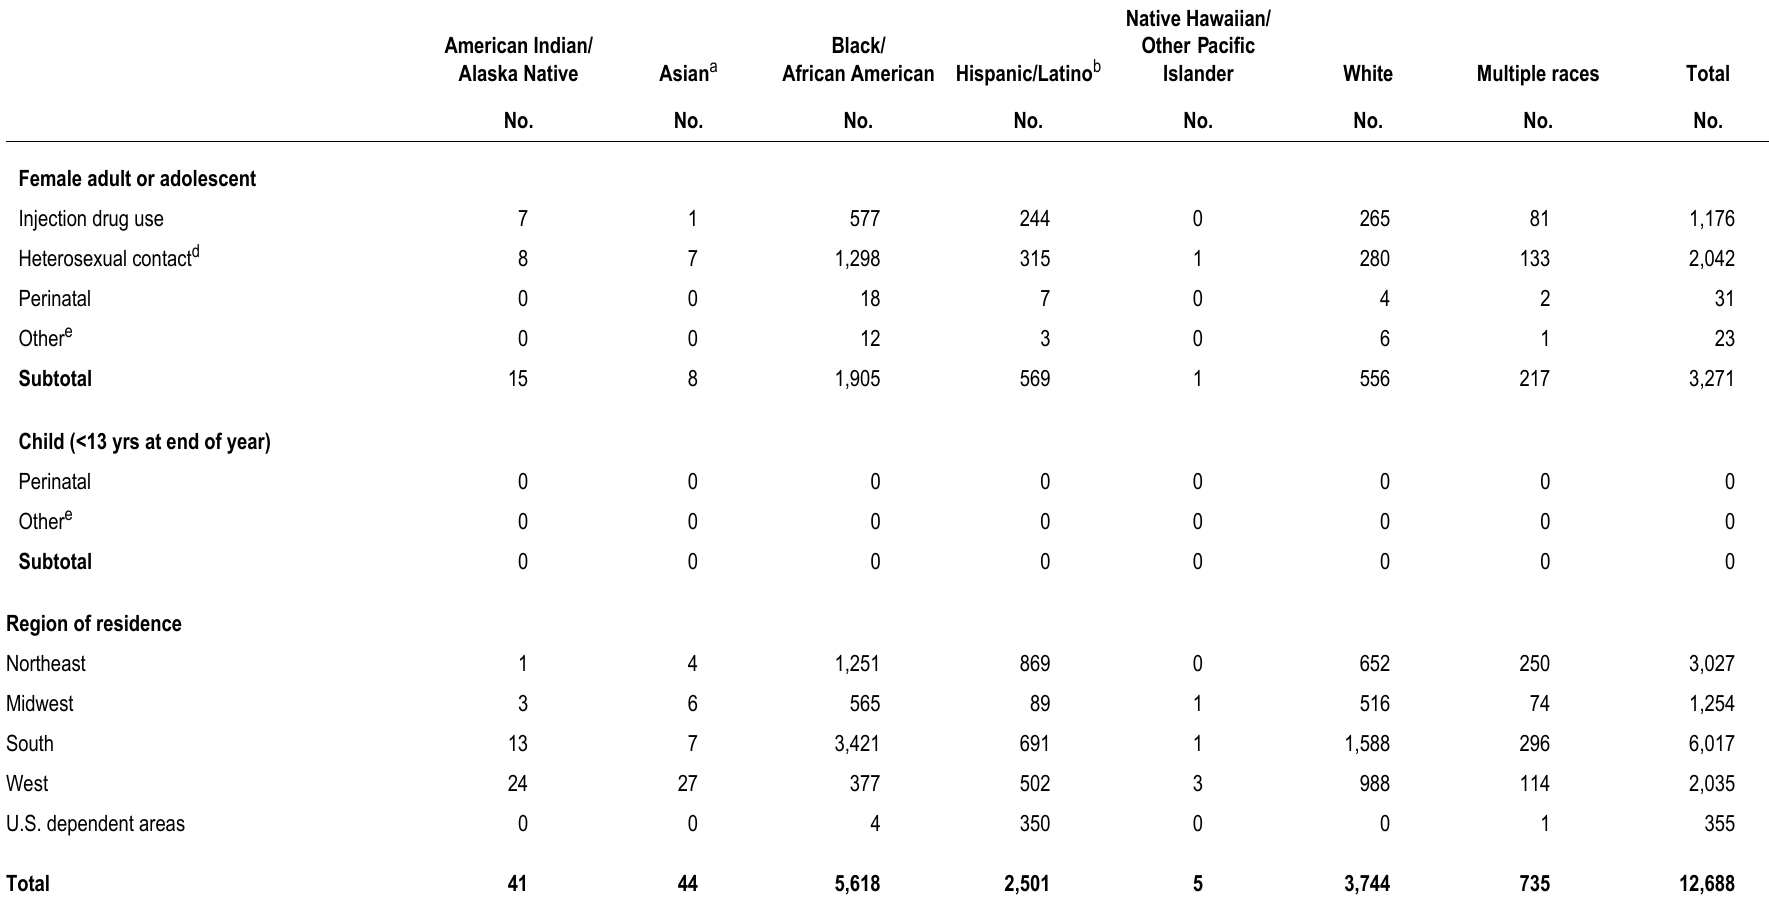
Table 15b. Deaths of persons with diagnosed HIV infection ever classified as stage 3 (AIDS), by race/ethnicity and selected characteristics, 2014—United States and 6 dependent areas